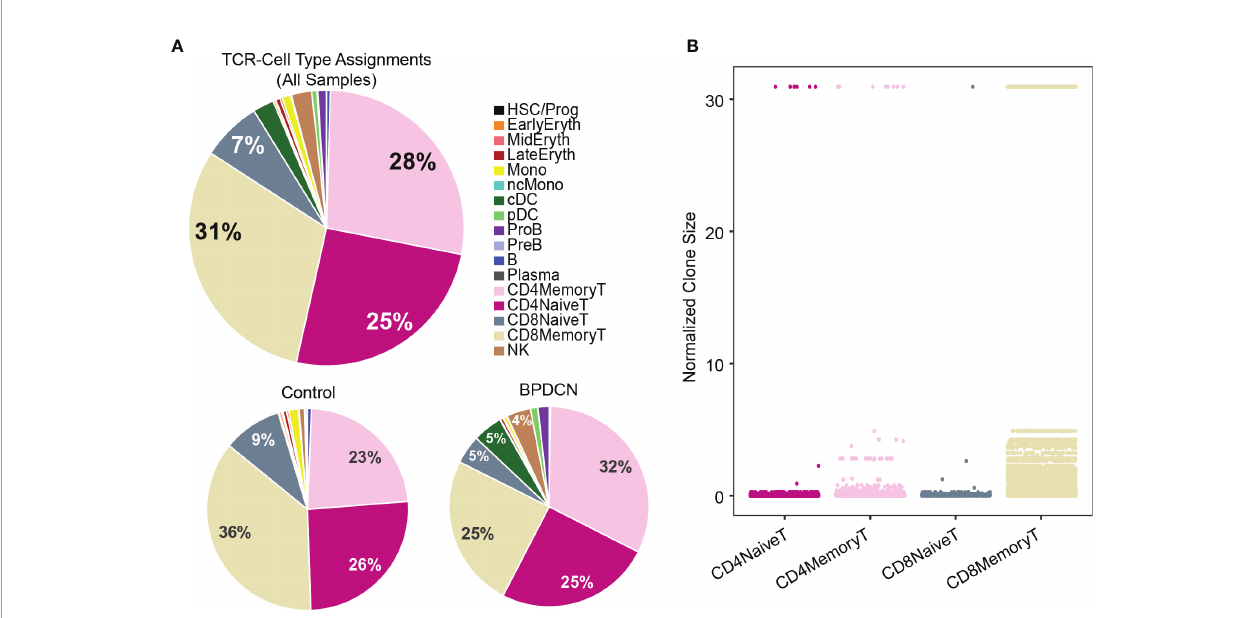
FIGURE 6 | TCR sequences are detected in T-cells and clonally expanded in CD8+ Memory T-cells. (A) Pie charts show cell type assignments of cells in which a TCR sequence was detected. (B) Dot plot shows normalized clone size of all the T-cells in which a TCR sequence was detected. The distribution of values differs between T-cell subsets ( P <